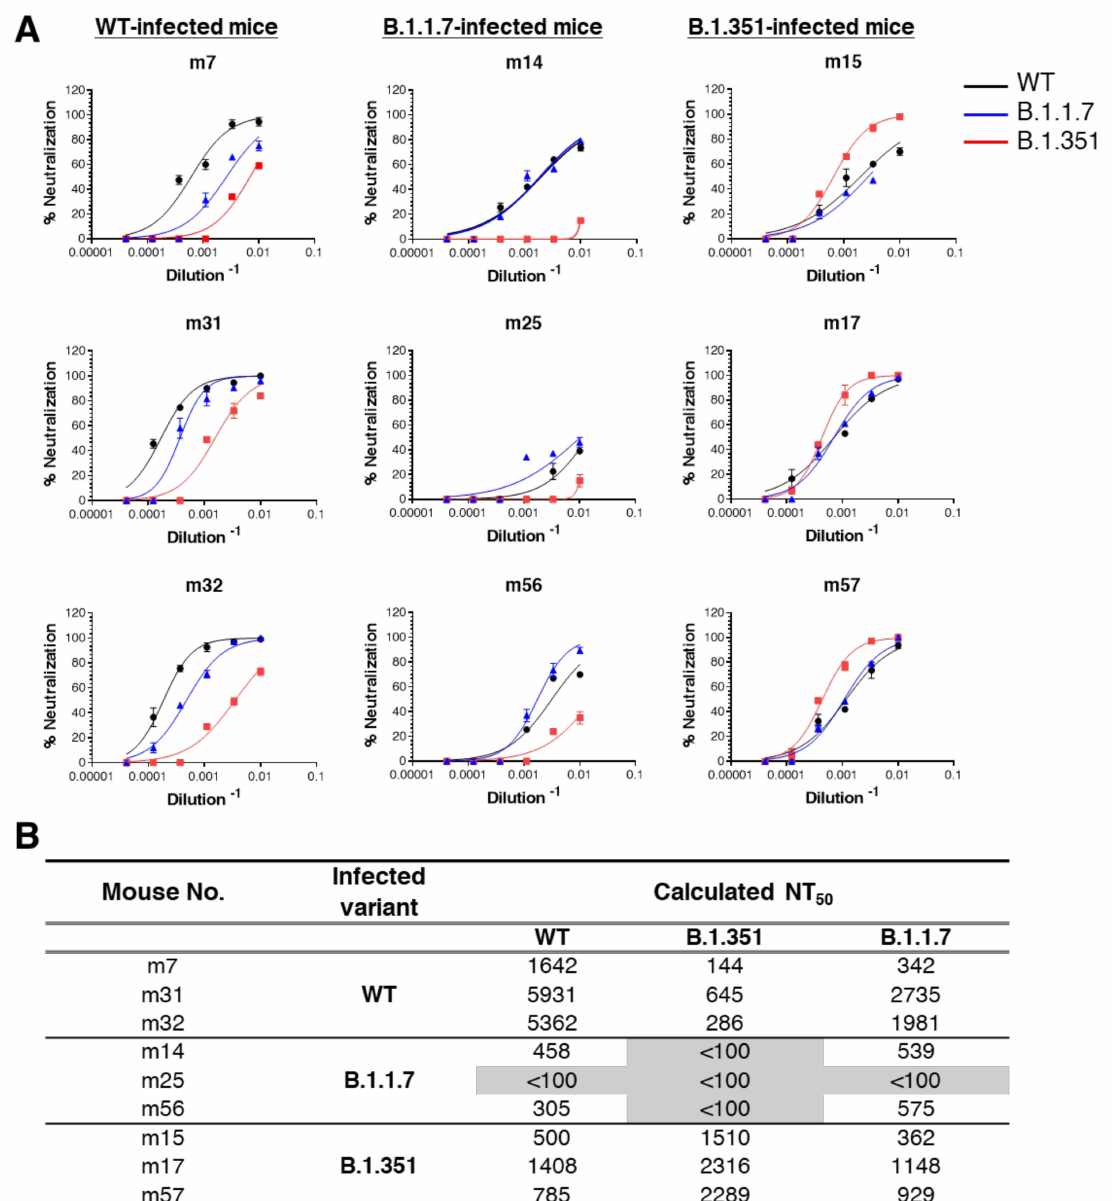
Figure 4. Cross-neutralization of SARS-CoV-2 WT, B.1.1.7 and B.1.351 variants. The in vitro neu- tralization capacity of serum samples collected from WT, B.1.1.7 or B.1.351 SARS-CoV-2 infected mice, was assessed by plaque reduction neutralization test (PRNT). The neutralization ability of each sample (at indicated dilutions) was assessed in duplicates against SARS-CoV-2 WT (black), B.1.1.7 (blue) and B.1.351 (red) variant. ( A ) Results are expressed as percent inhibition compared to control without serum. ( B ) Summary of the calculated NT50 values (dilution-1). NT50 <100 indicates low neutralization capacity, emphasized by gray